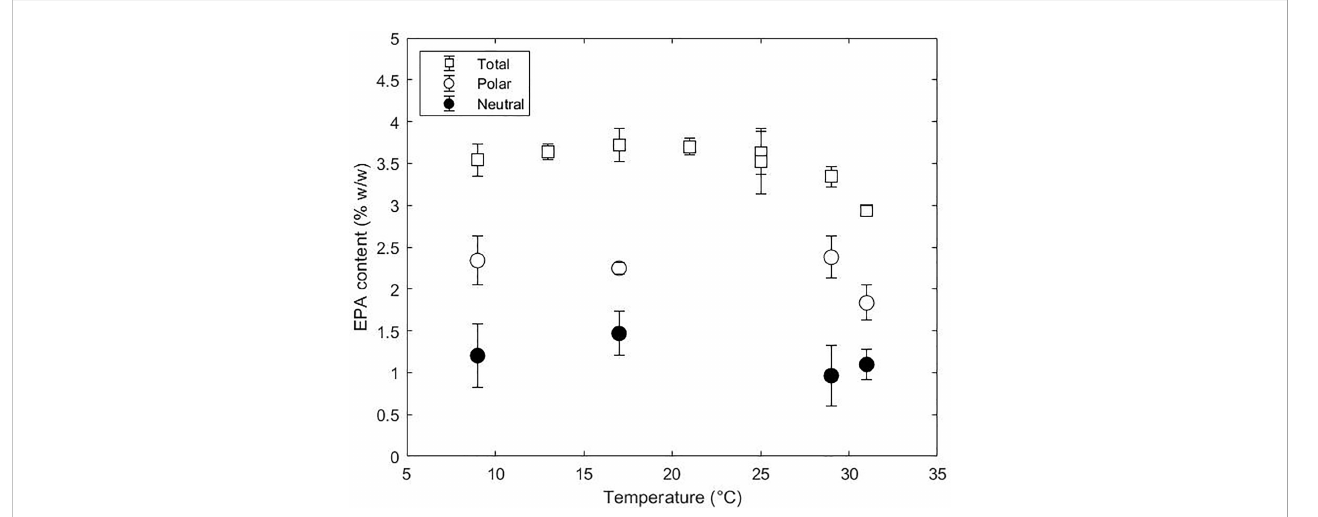
FIGURE 5 Total EPA content (%, w/w) and distribution between polar and neutral lipids at 9, 17, 29 and